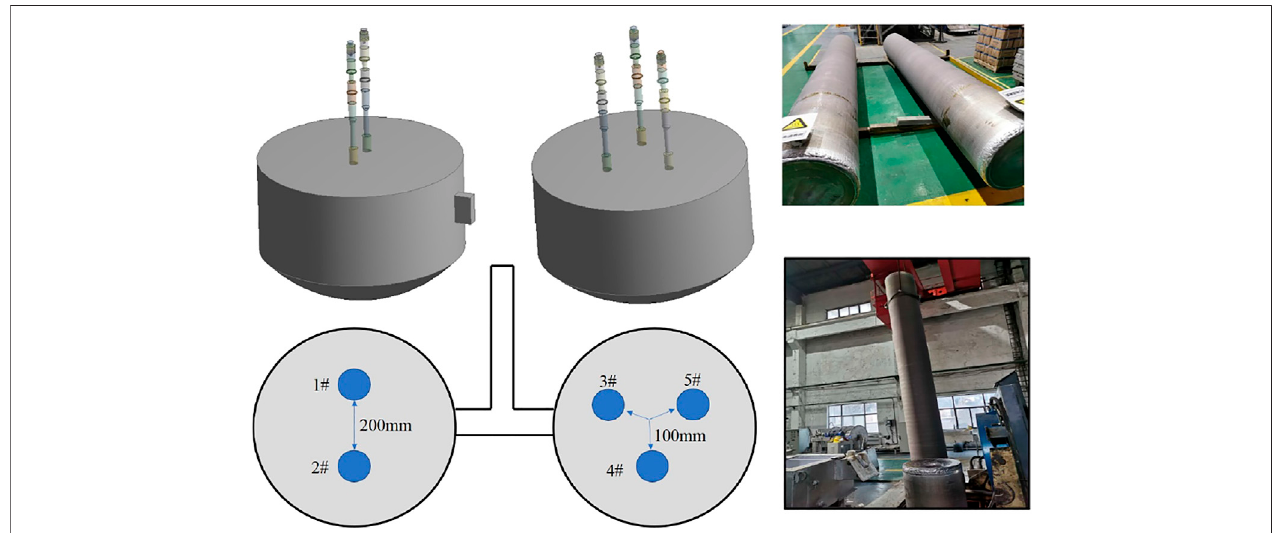
FIGURE 1 | Casting process